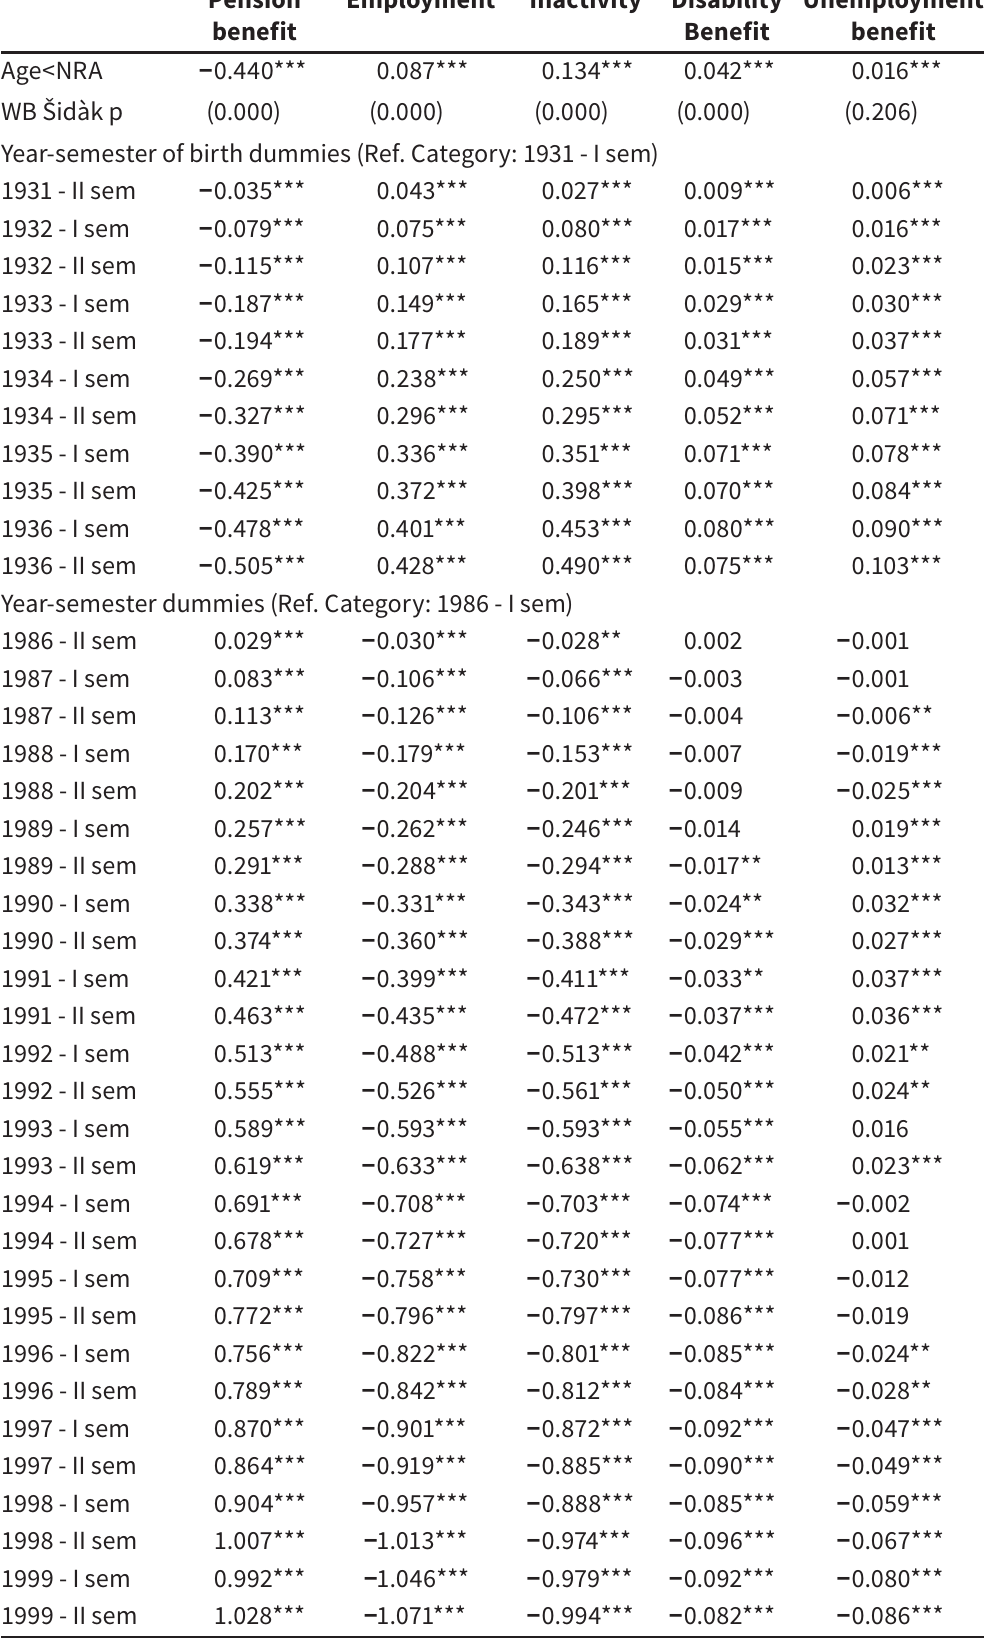
Table C2 The average effect of raising the NRA on different labor market outcomes Eq. (2) Pension Employment Inactivity Disability benefit